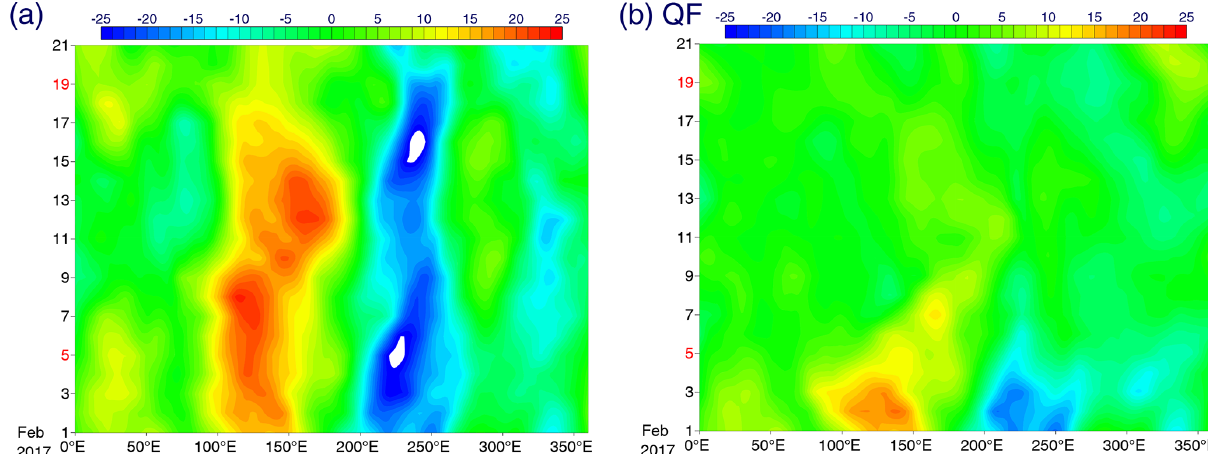
Figure 8. Time–longitude sections of the 150hPa stream function along the Equator (15 ◦ S–15 ◦ N) for the 20d period from 1 February: (a) analysis and (b)